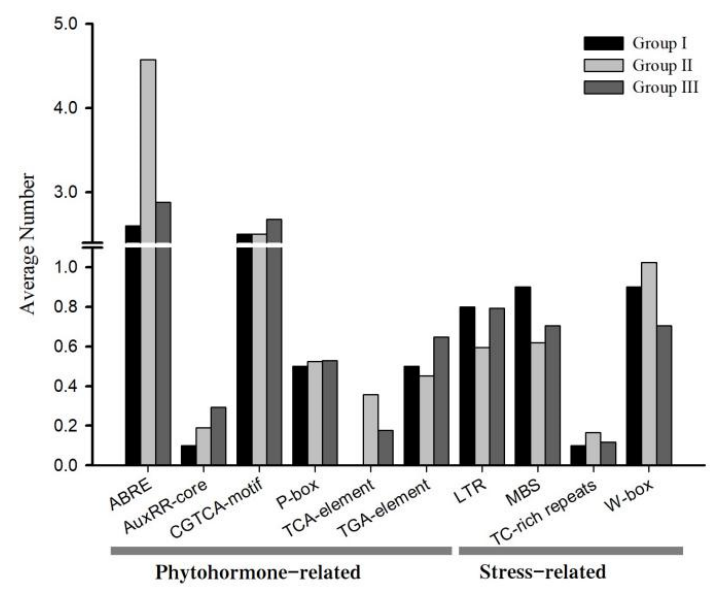
Figure 8. Distribution of cis -elements in promotor of HvWRKYs in each group. Six cis -elements on the left side were phytohormone response elements and four elements on the right side were stress related elements.